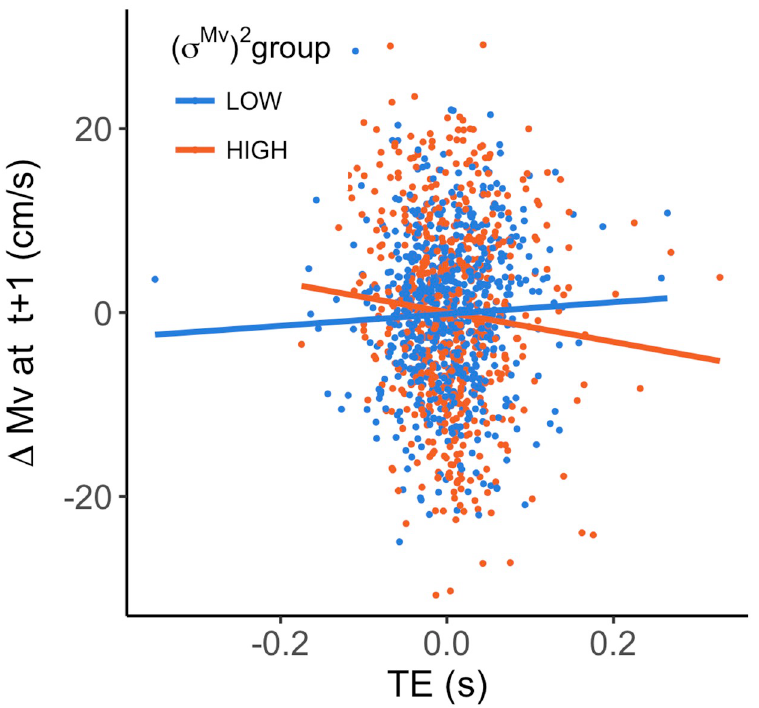
Fig 5. The relationship between the baseline TE on trial t-1 and the subsequent change in Mvel. Dots represent individual trials for subjects within the HIGH (orange) and LOW (blue) ( σ Mv ) 2 group. The lines indicate the predicted slope of the